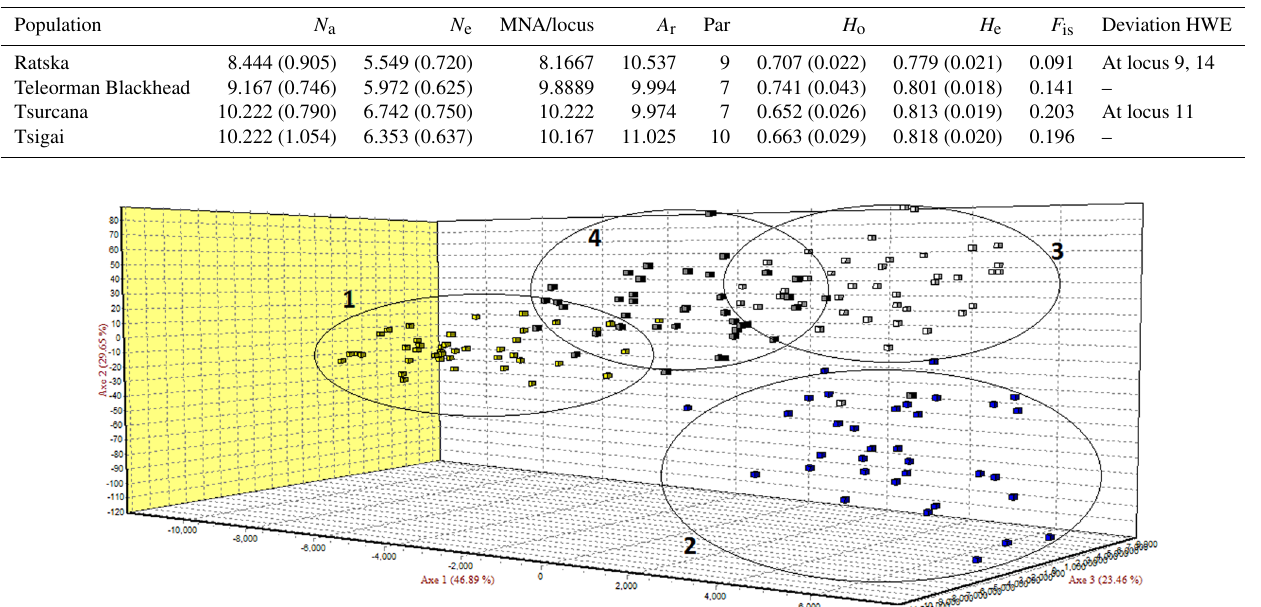
Figure 1. Factorial correspondence analysis (FCA) of four local sheep breeds from Romania: (1) Ratska, (2) Teleorman Blackhead, (3) Tsur- cana and (4)